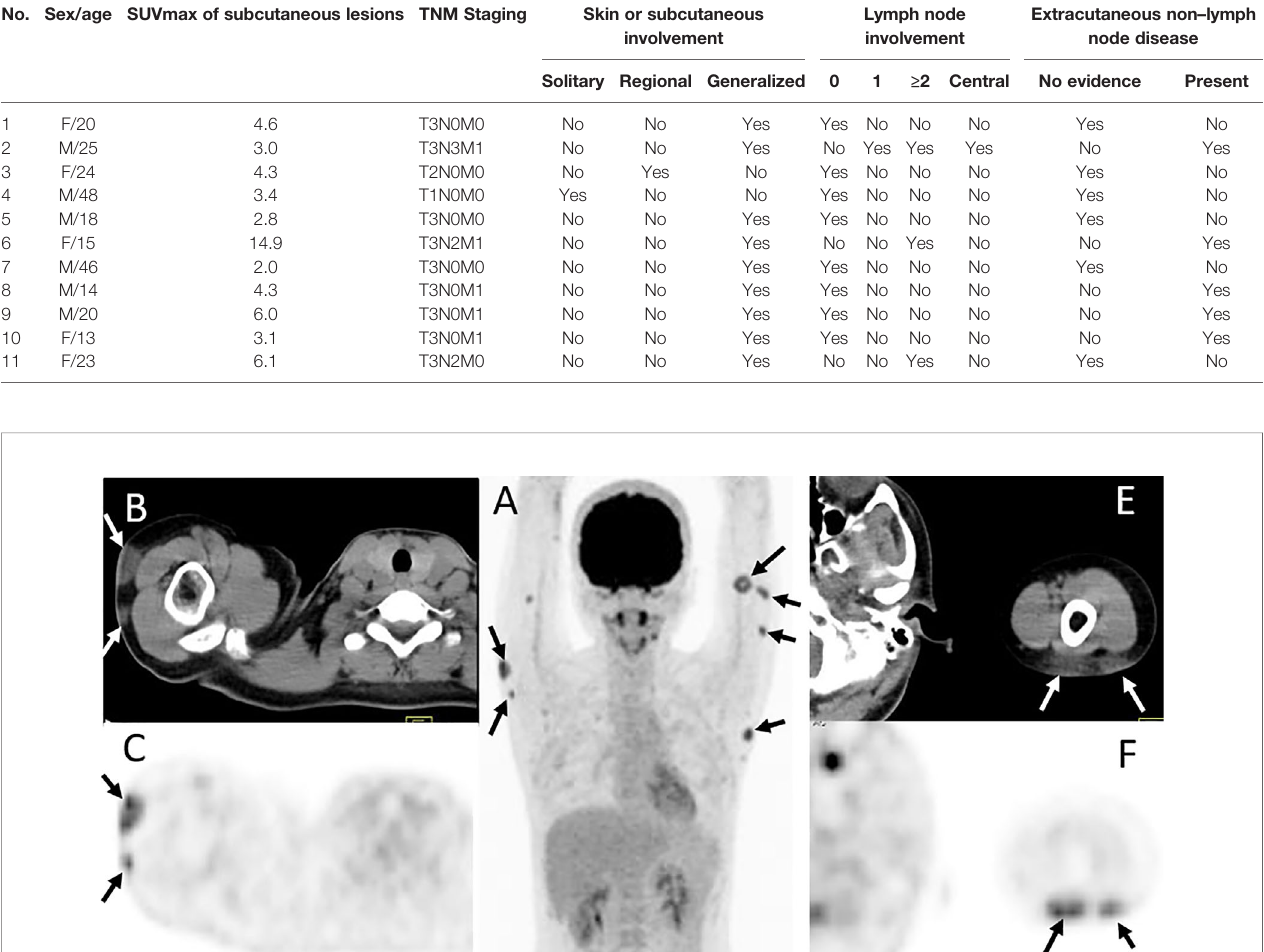
Lymph node Extracutaneous non – lymph involvement involvement node disease